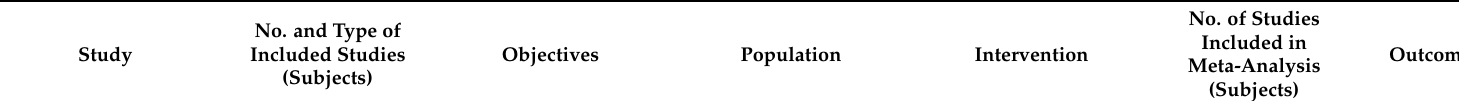
Table 1. Characteristics of the included